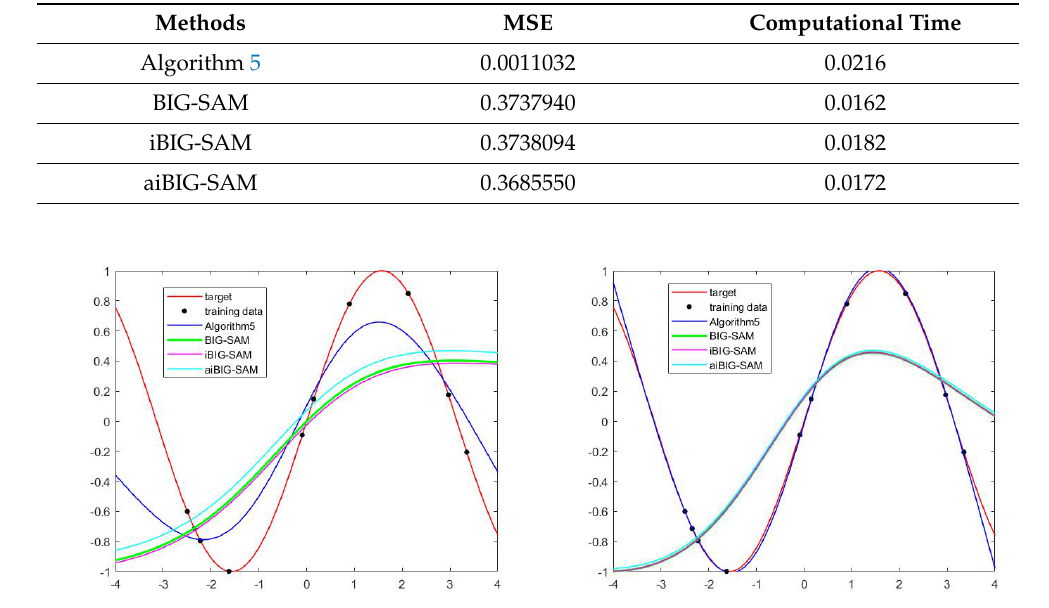
Table 2. Numerical results for regression of a sine function with 500 iterations.